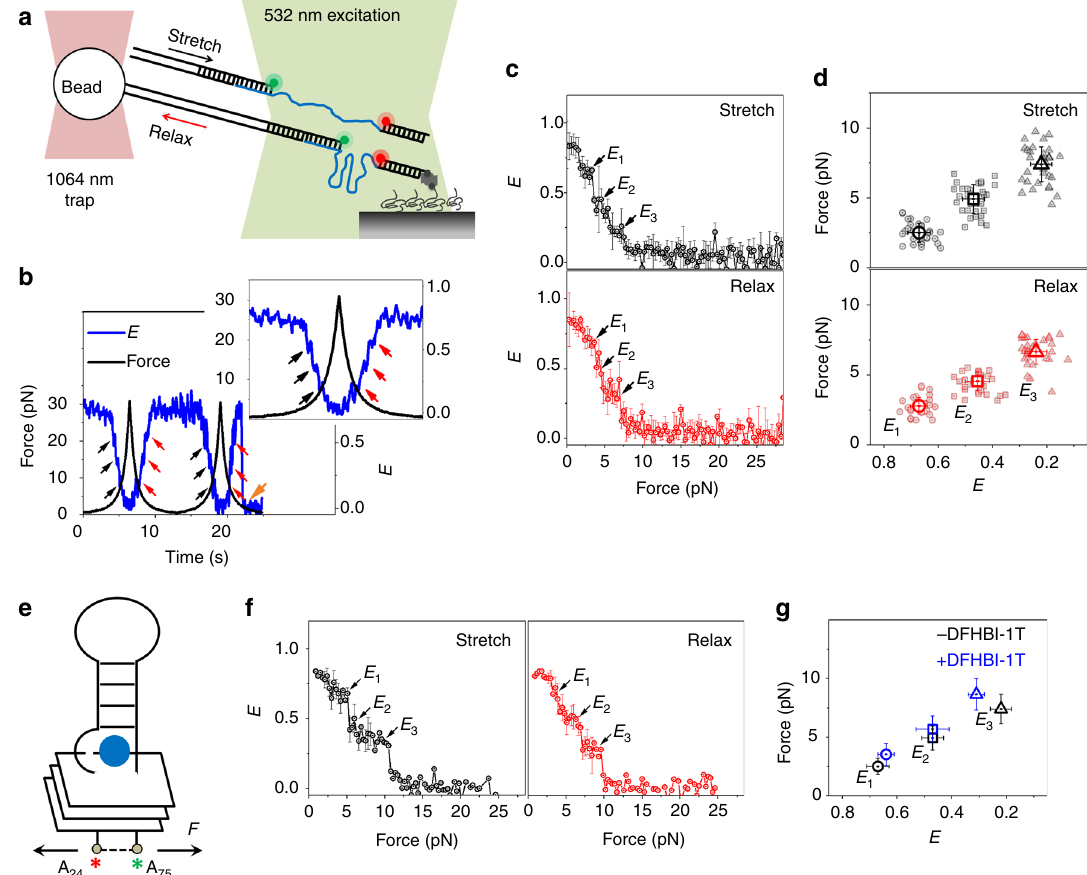
Fig. 2 Conformational dynamics of Spinach2 under tension. a Schematic of integrated fl uorescence-force spectroscopy assay: the Spinach2 construct is immobilized on a neutravidin coated quartz surface via a biotinylated strand. The other end is connected to an optically trapped 1 μ m diameter bead through a λ -DNA. Force was applied by translating the microscope stage at a speed of 455 nm s − 1 . FRET was measured between Cy3 (donor) and Cy5 (acceptor) as a function of force. b A representative time trace of E and the applied force from a single-molecule of Spinach2 over two pulling cycles (20 ms integration time). The black and red arrows represent E steps during stretching and relaxation, respectively. The orange arrow denotes photobleaching of the fl uorescent dyes. A blown-up image of cycle 1 is shown in the inset. c Average E vs force response from molecules undergoing stretching (top) and relaxation (bottom). The errors represent standard errors. ( N = 48). d Force vs E response corresponding to the steps at E 1 , E 2 , and E 3 under stretching (top) and relaxation (bottom). The average force and E values are emboldened. Source data are provided as a Source Data File. e A schematic of Spinach2 molecule under tension, in the ligand-bound state. DFHBI-1T is represented as a blue sphere. The Cy5 and Cy3 dyes adjacent to A 24 and A 75 are shown as red and green asterisks, respectively. Force ( F ) applied on the construct is shown by arrows. f Average E vs force response from molecules during stretching (left) and relaxation (right) in the presence of DFHBI-1T. ( N = 36). g Comparison of the average forces stretching forces corresponding to the three unfolding E states in the absence and presence of DFHBI-1T. Source data are provided as a Source Data